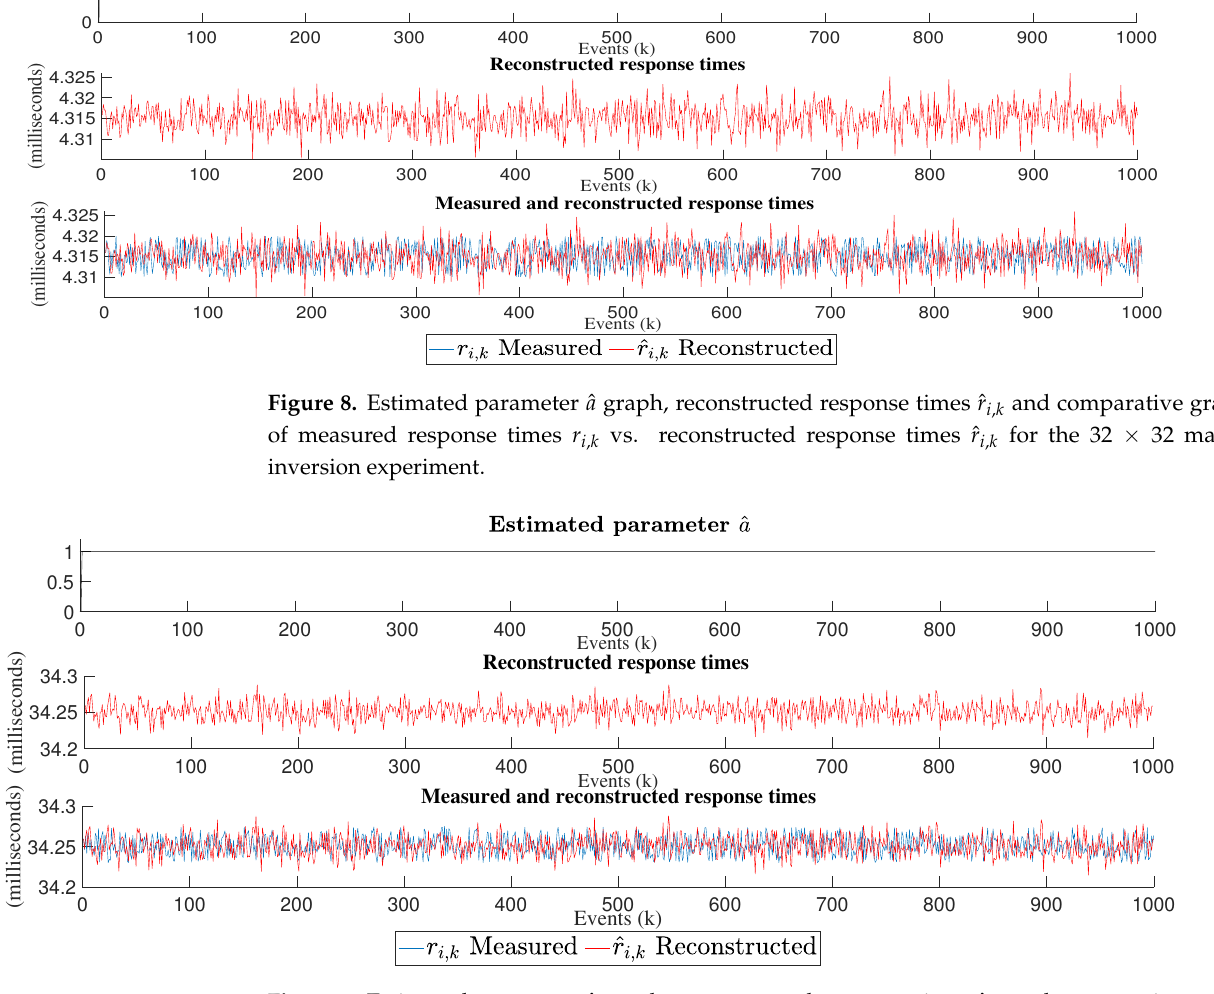
Figure 9. Estimated parameter ˆ a graph, reconstructed response times ˆ r i , k and comparative graph of measured response times r i , k vs. reconstructed response times ˆ r i , k for the 64 × 64 matrix inversion